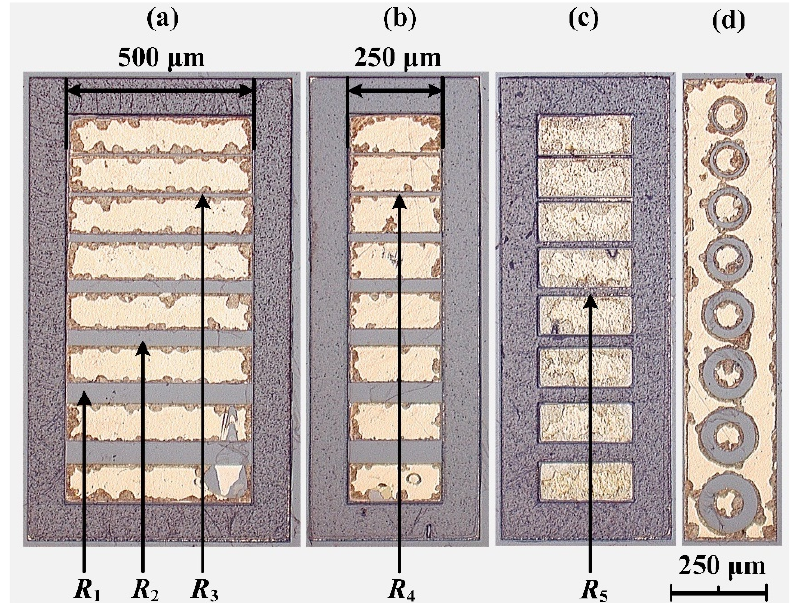
Figure 2. Photograph of ohmic contact pads fabricated on the sample obtained using optical micro- scope: ( a ) wide TLM structures (W-TLM) with contact width of 500 µ m, ( b ) narrow TLM structures (N-TLM) with contact width of 250 µ m, ( c ) I-TLM structures with contact width of 250 µ m and removed GaN epitaxial layer between the contact pads, and ( d ) CTLM with diameter of central contact pad of 80 µ m. Labels R 1 , R 2 , and R 3 denote resistors on the W-TLM structures with contact separation of 55 µ m, 45 µ m, and 12.5 µ m, respectively. Label R 4 denotes the resistor on the N-TLM structure with contact separation of 12.5 µ m. Label R 5 denotes the I-TLM structure with contact separation of 20 µ m.